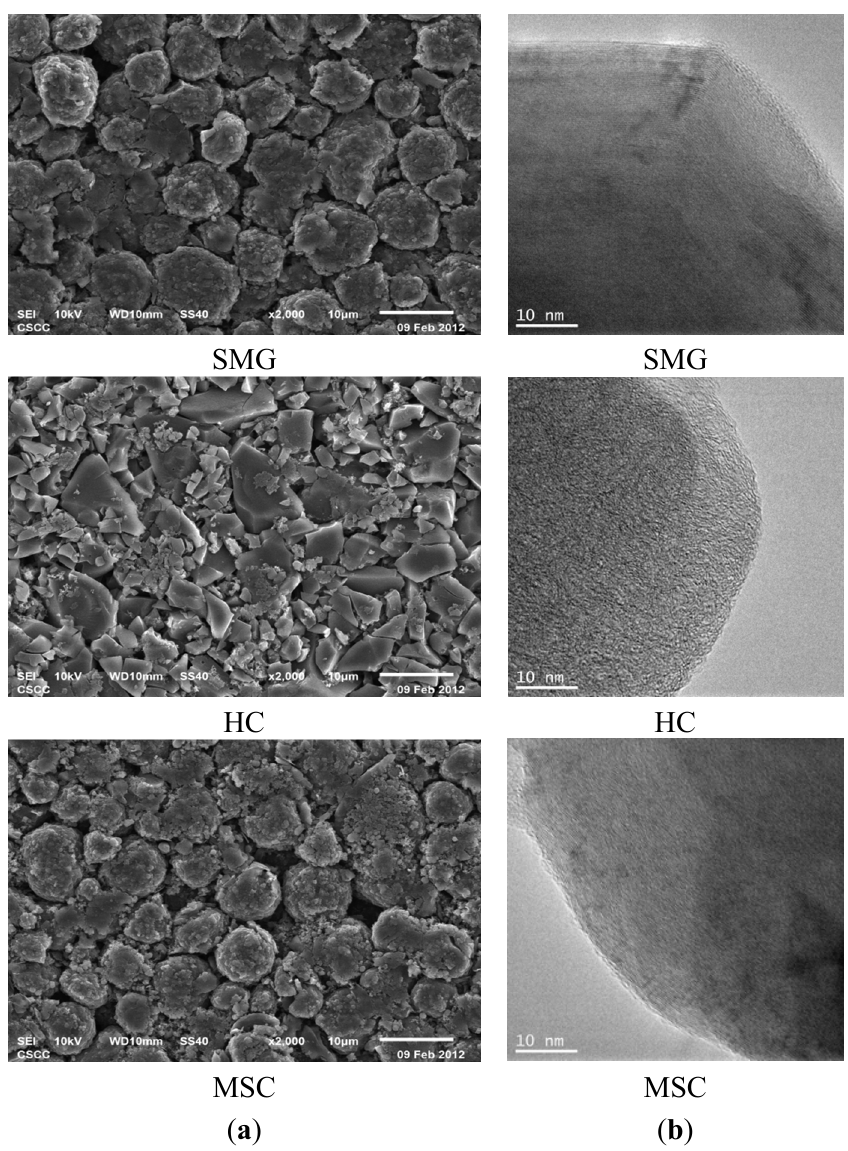
Figure 1. ( a ) SEM and ( b ) TEM images of SMG, HC, and